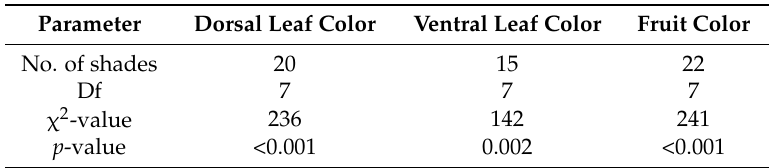
Table 3. Fischer’s exact χ 2 -square test results of leaf and fruit colors of sea buckthorn across all populations in the Gilgit and Baltistan regions, northern